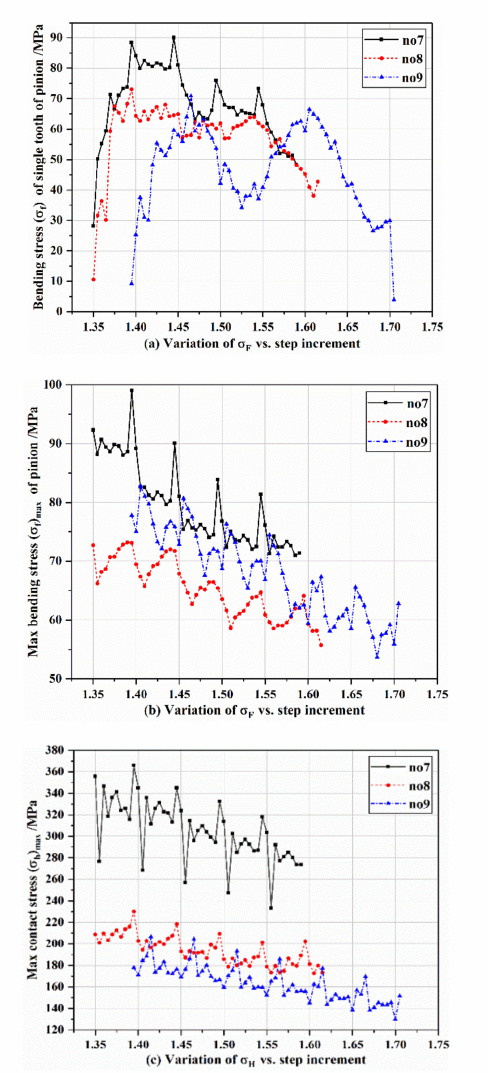
Figure 14. Influence of addendum coefficient on bending and contact stresses. ( a ) Bending stress of single tooth of pinion; ( b ) maximum bending stress of pinion; ( c ) maximum contact stress of